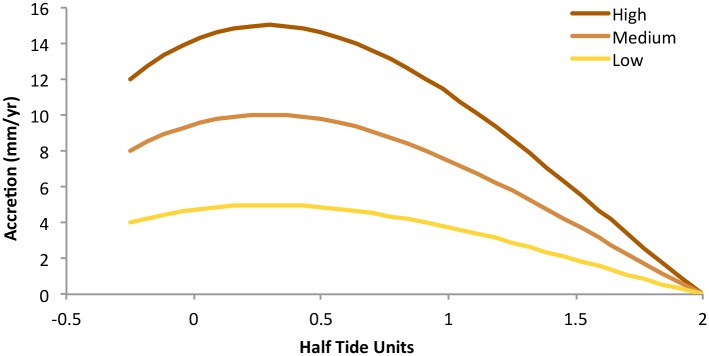
The three generic accretion curves used to parameterize high, medium and low marsh accretion rates in SLAMM models.Elevation is in Half Tide Units [HTU]—the difference between Mean Higher High Water or Mean Lower Low Water and Mean Tide Level.